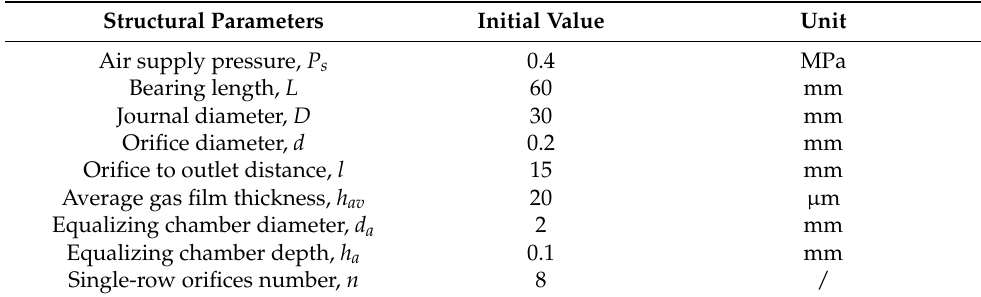
Table 1. Structural parameters of aerostatic bearing.